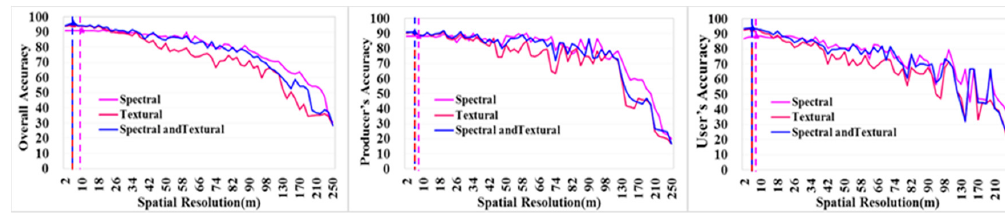
Figure 5. The variations in overall, producer's and user’s accuracies of mapping PMF in Jizhou (vertical line show the highest accuracy of different features sets). line show the highest accuracy of different features sets). (vertical line show the highest accuracy of different features sets).